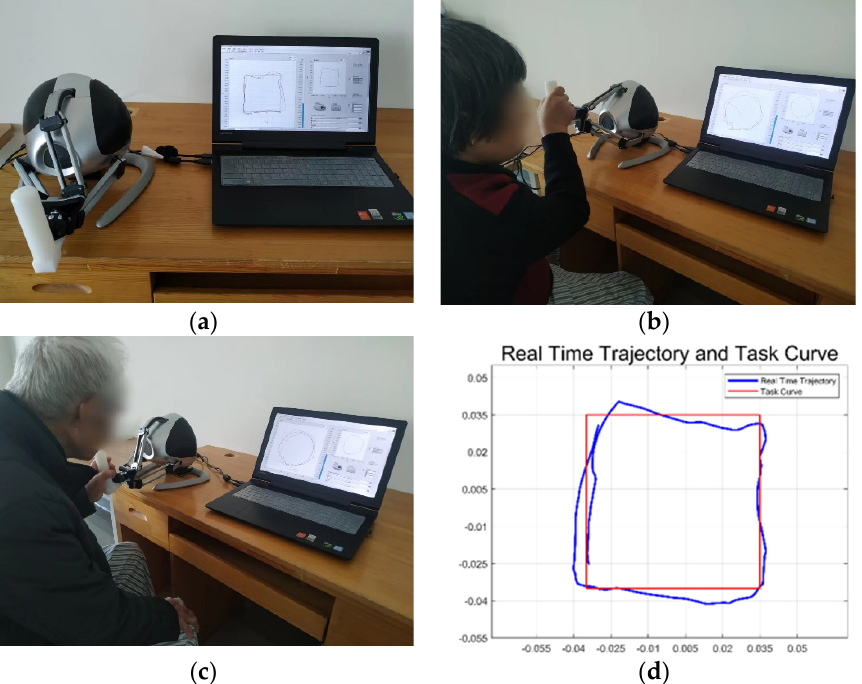
Figure 4. Scene of rehabilitation evaluation experiment and the movement trajectory of the subject. ( a ) The experimental scene of wrist motor function assessment. ( b ) The female subject participated in the wrist assessment experiment by manipulating the Novint Falcon end modification handle with her right hand. ( c ) The male subject participated in the wrist evaluation experiment by manipulating the Novint Falcon end modification handle with his left hand. ( d ) The comparison between the real-time trajectory of the subject and the given graphical curve during the experiment.